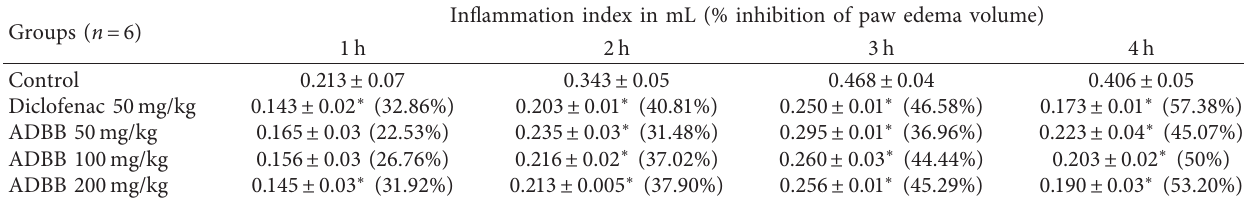
Table 2: Effect of aqueous extract of D. butyracea bark on carrageenan-induced rat paw edema. Groups ( n � 6)